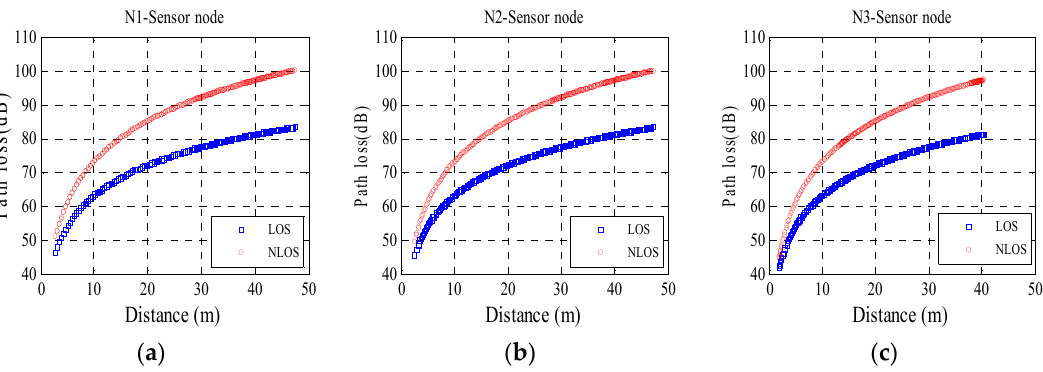
Figure 5. Path loss between beacon nodes and sensor node for LOS and NLOS ( a ) N1-sensor node, ( b ) N2-sensor node, and ( c ) N3-sensor node.